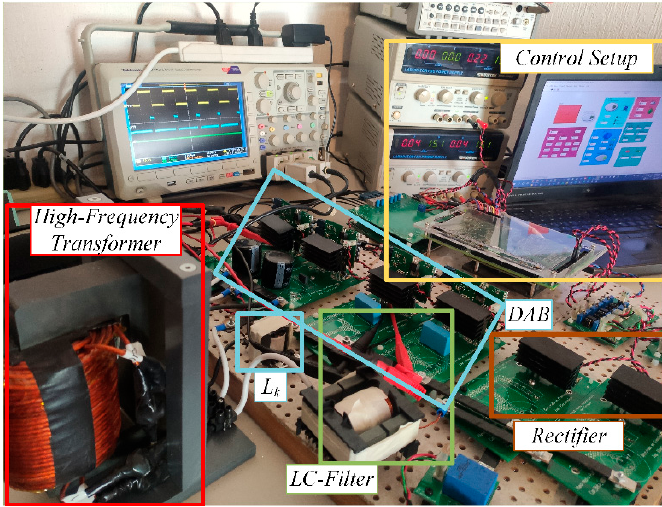
Figure 8. Prototype photograph.